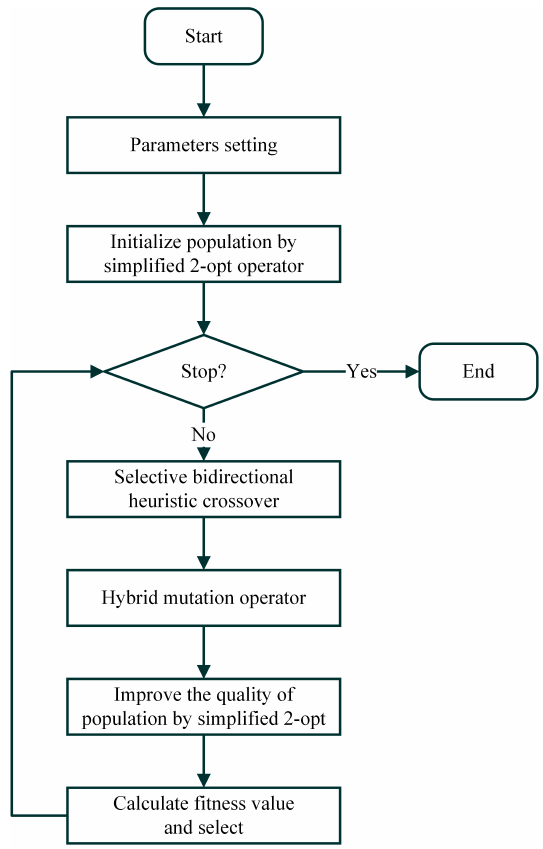
Figure 1. Flowchart of the proposed